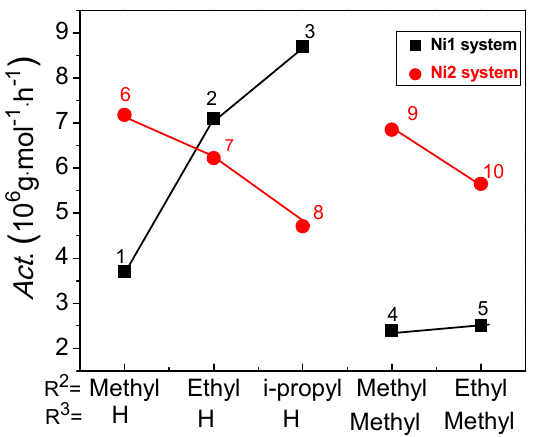
Figure 1. The variation of experimental activities as a function of R 2 and R 3 substituents for Ni1 and Ni2 complexes, respectively. Table 1. The experimental catalytic activities and reaction conditions for the nickel complexes. Complex